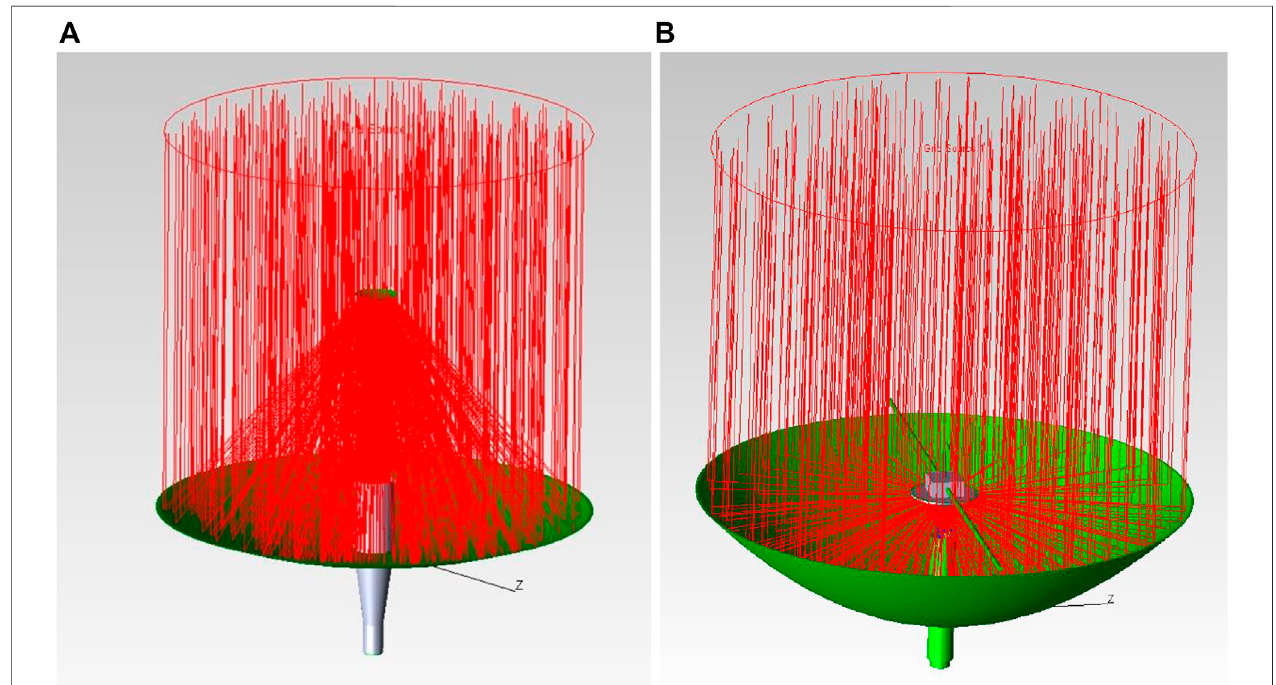
FIGURE 6 | Ray-tracing results of the concentrator modules: (A) CM-1 and (B) CM-2.